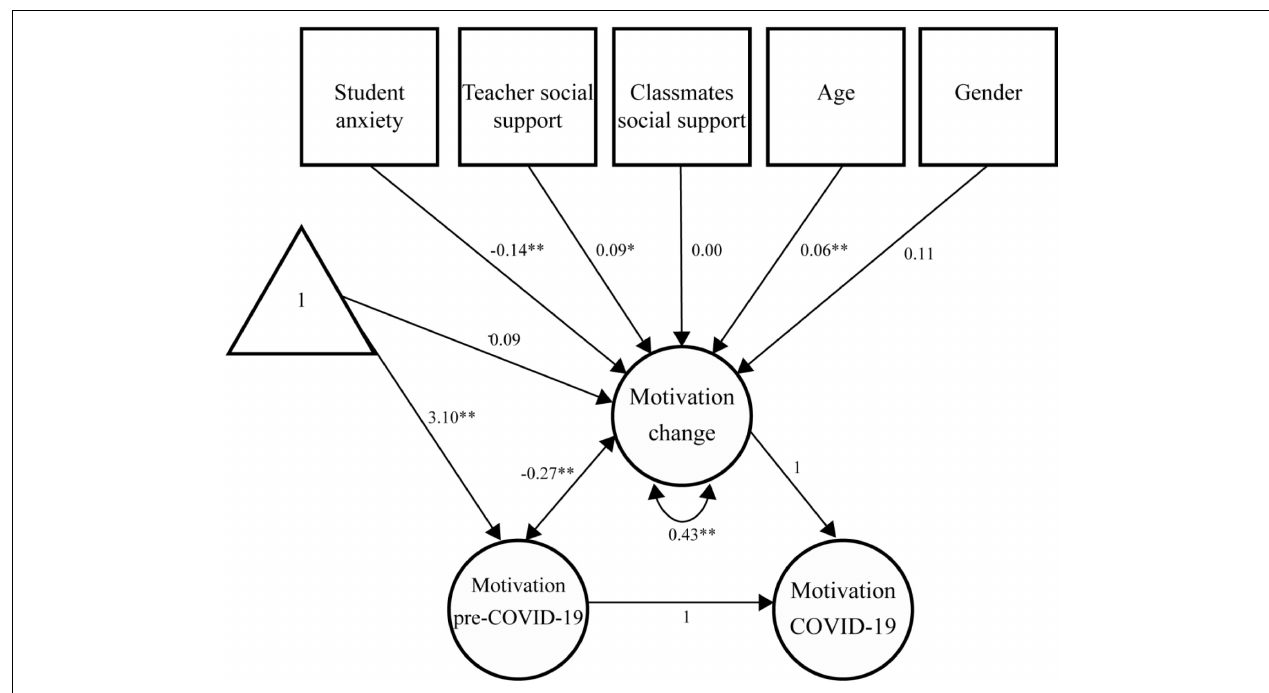
FIGURE 1 | Unstandardized model estimates. For simplicity, only estimates of interest of the LCSM are presented. Shapes follow standard figural notation for structural equation modeling: triangle—intercepts (estimate mean levels), squares—manifest/observed variables, circles—latent variables, one-headed arrows—unidirectional effects (regression weights or means), and double-headed arrows—(co-)